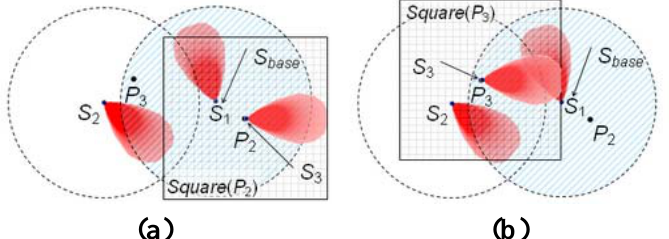
Figure 9. An example of the scoring process for Case